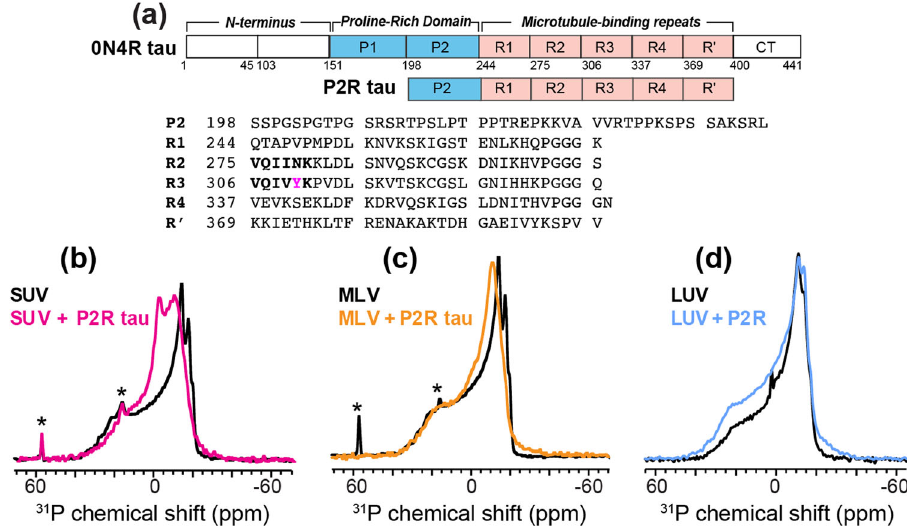
Fig. 1 P2R tau binds and increases the mobility of SUV membranes. a Amino acid sequence of P2R tau. The sequence diagram of full-length 0N4R tau is shown for comparison. b Static 31 P NMR spectra of freshly prepared SUVs without (black) and with (magenta) P2R tau. Tau binding reduced the 31 P CSA of the membrane, as shown by the emergence of an isotropic peak. c Static 31 P NMR spectra of freshly prepared MLVs without (black) and with (orange) P2R tau. d Static 31 P NMR spectra of freshly prepared LUVs without (black) and with (cyan) P2R tau. No obvious lineshape changes are observed for the MLV and LUV samples upon tau binding. These 31 P spectra were measured at a sample temperature of 295 K. All three membranes consist of POPC, POPE, POPS and